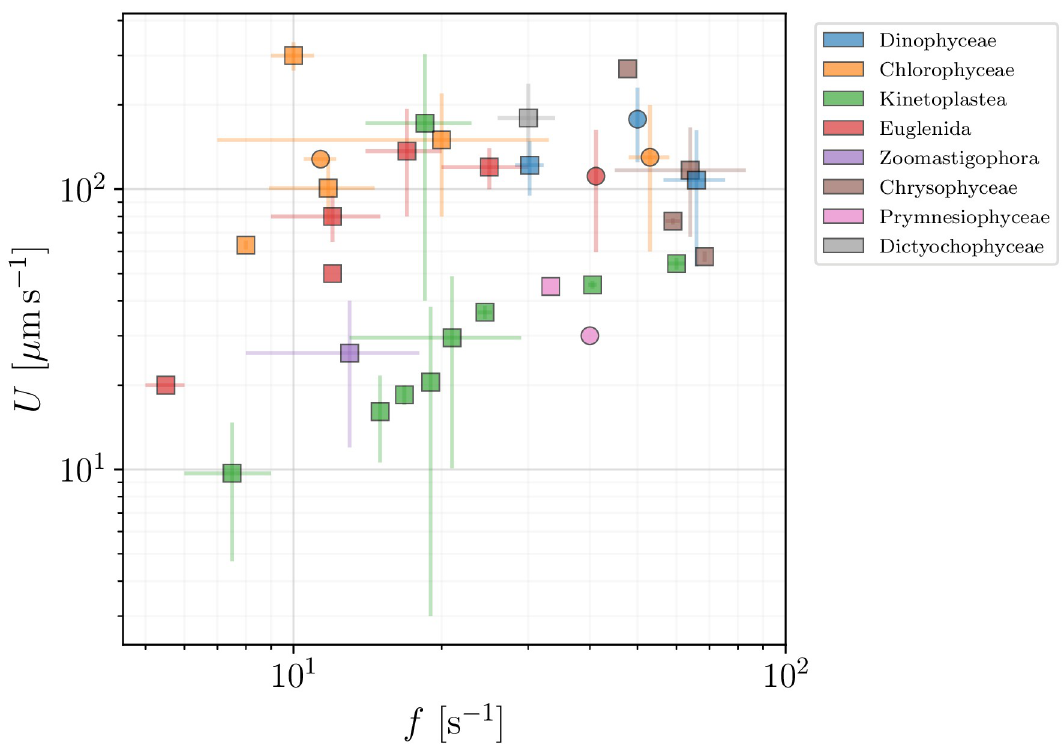
Fig 10. Swimming speed, U ( μ m s − 1 ), plotted versus the frequency of flagellar beat, f (s − 1 ), for flagellated eukaryotes in our dataset (excluding spermatozoa and ciliates). Colours mark different classes and sub-classes. Wave-producing organisms are plotted in squares and the remaining flagellated eukaryotes are plotted in